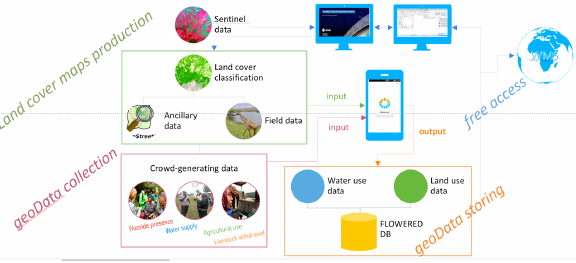
Figure 2. Methodological